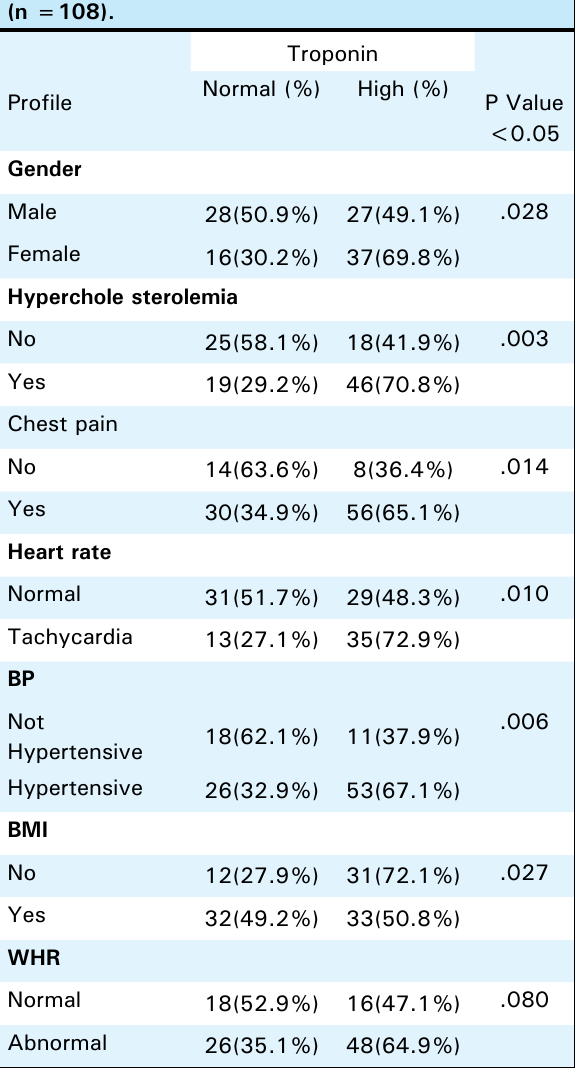
table 4. Correlation of clinical profile with Troponin (n =108).